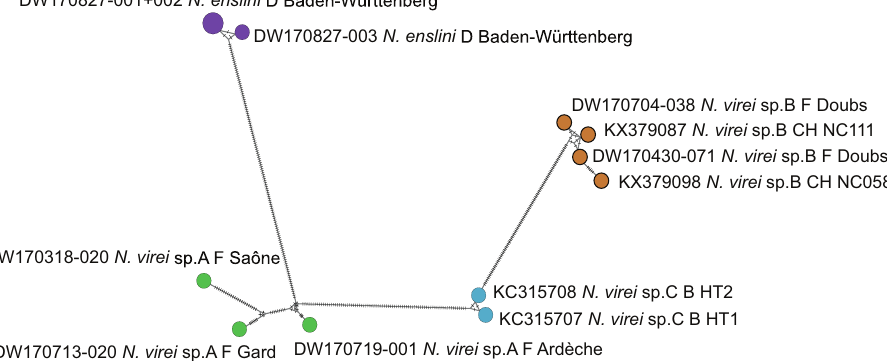
Figure 4. Haplotype network of COI of the Niphargus enslini – Niphargus virei clade (original data and data downloaded from GenBank). Colors distinguish the four putative species delimited by applying ABGD to the COI Niphargus